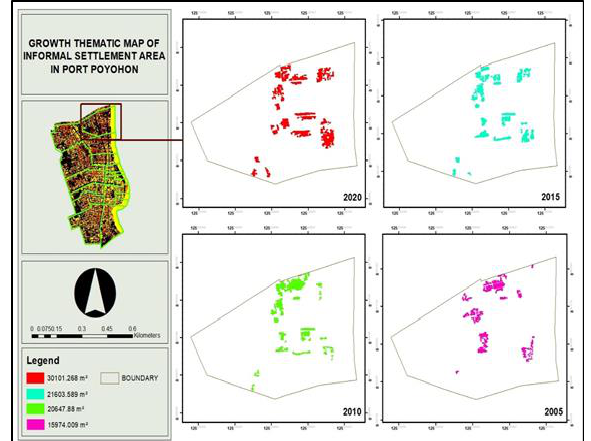
Figure 14. Thematic Map of Brgy. Port Poyohon from